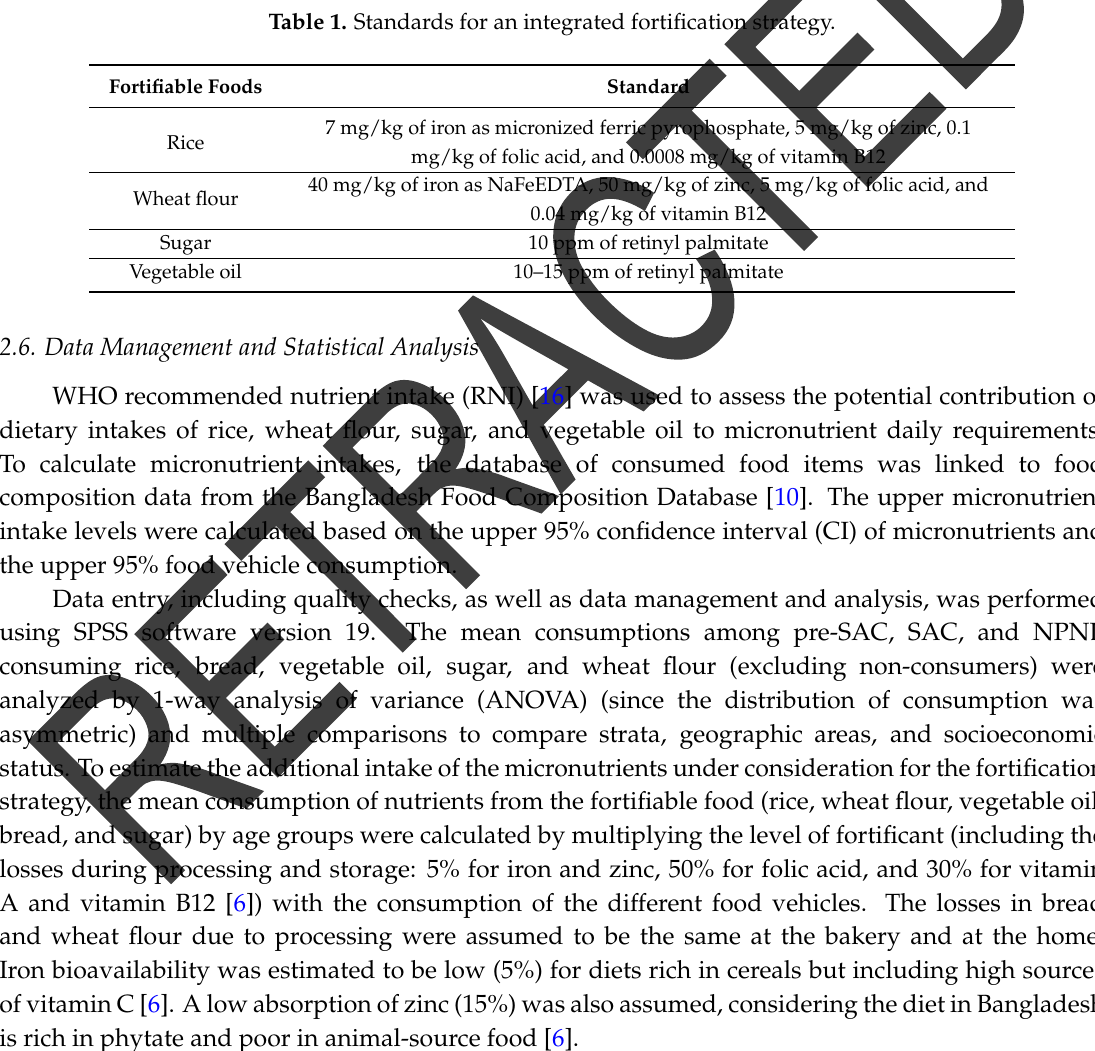
Table 1. Standards for an integrated fortification